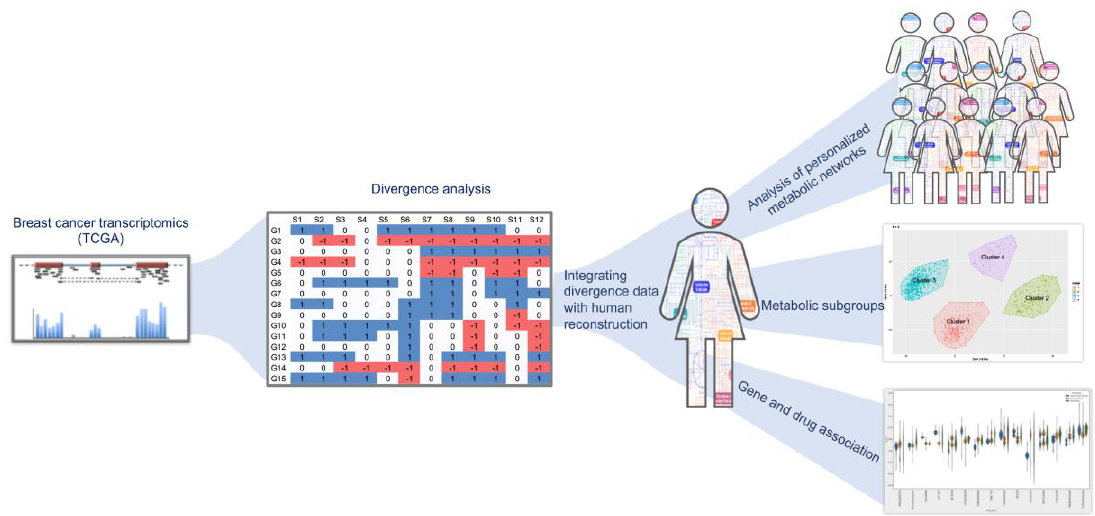
Figure 1. Overview of the study design. The breast cancer expression dataset from The Cancer Genome Atlas (TCGA) was converted to ternary format using divergence analysis (shown in the middle panel) [4]. The divergence values were integrated with human reconstruction and pruned to obtain personalized metabolic networks. The right side of the figure panel shows the identification of metabolic subgroups in the samples using unsupervised clustering. From our analysis, we identified important reactions and genes in cancer versus normal and used this information to associate drugs that can target them (bottom panel on the